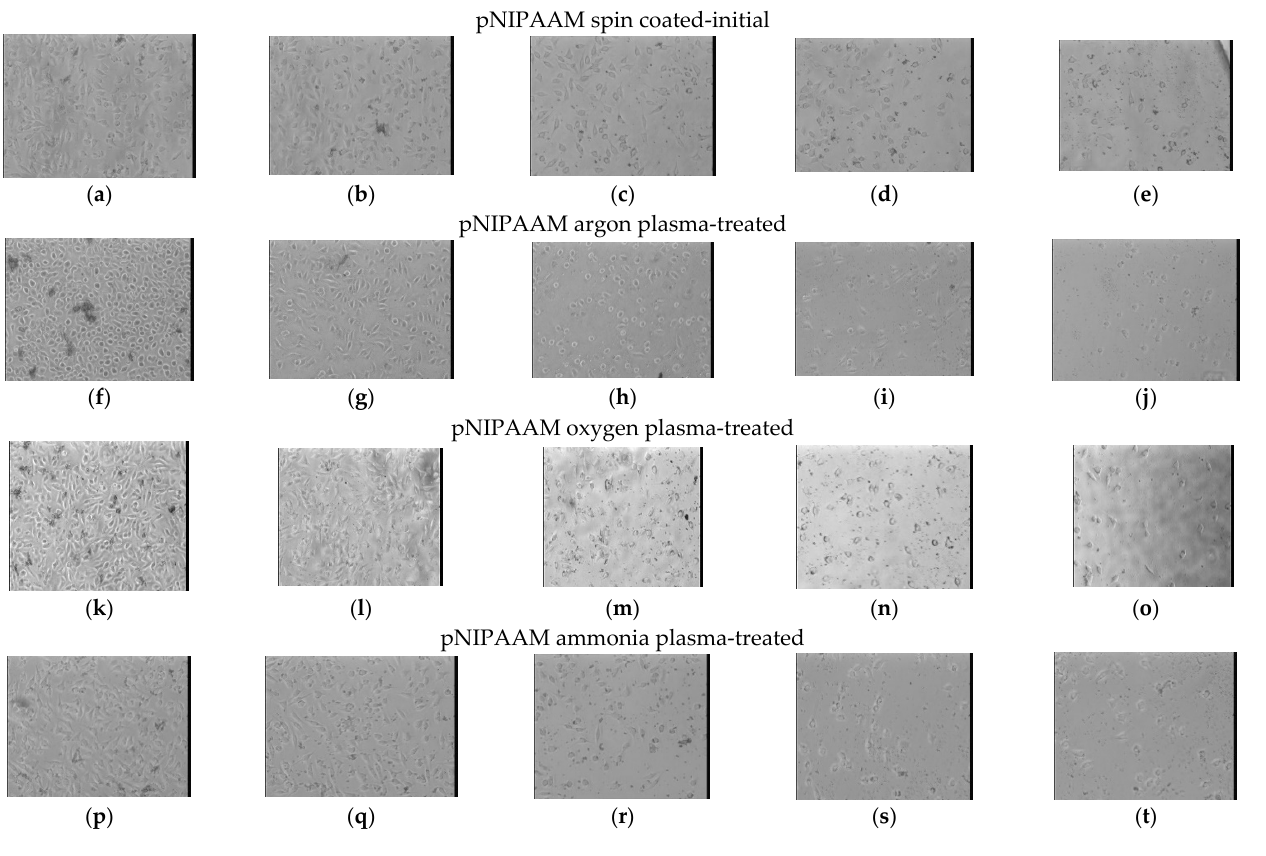
Figure 11. Cell detachment sequence images of PNIPAAM surfaces, initial and treated in argon, oxygen and, respectively, ammonia plasma for 30 s, initial ( a , f , k , p ) 0 min; and respectively upon cooling, after: ( b , g , l , q ) 15 min; ( c , h , m , r ) 25 min; ( d , i , n , s ) 35 min; and ( e , j , o , t ) 45 min.